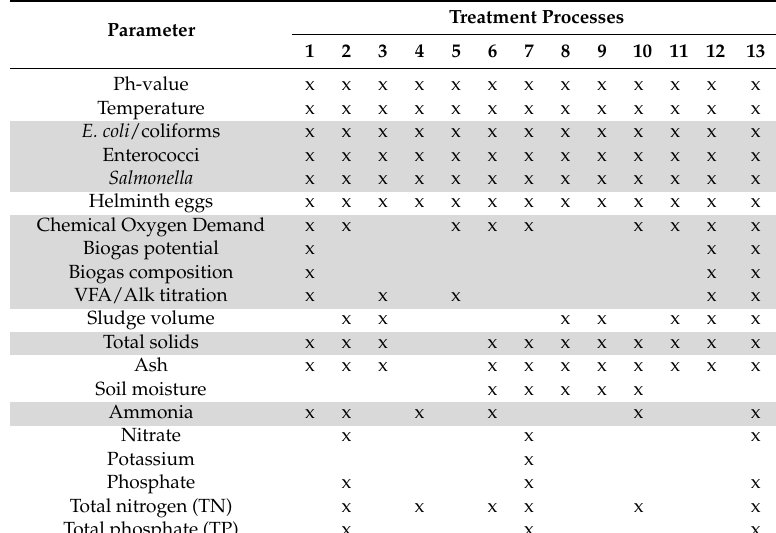
Table 1. Parameters included, and processes considered in the field lab; parameters highlighted in grey were modified for field